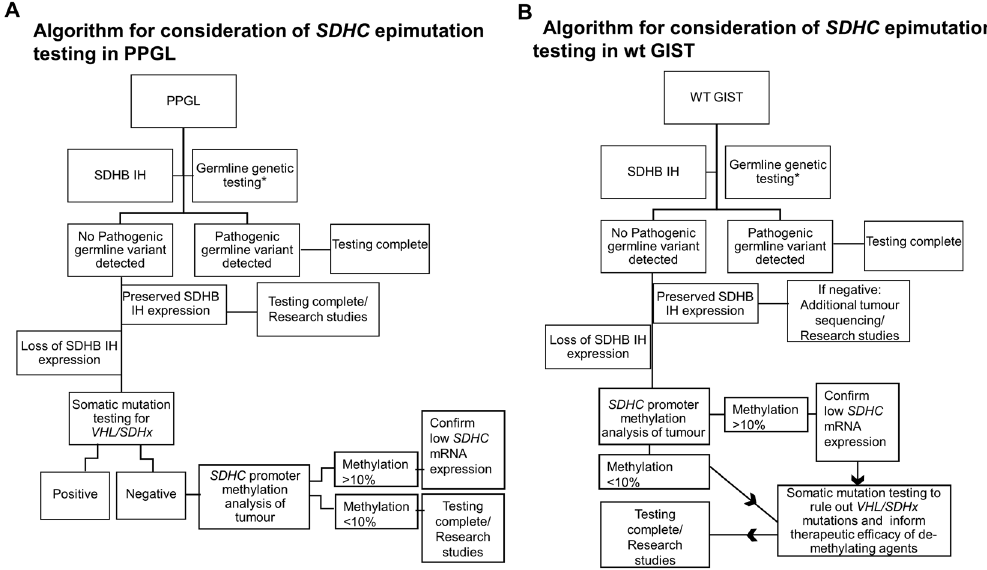
Figure 4. Illustrates a proposed work flow for the investigation of SDHC promoter methylation in a clinical setting for ( A ) PPGL and ( B ) wtGIST (defined as a GIST with no identified somatic mutation in KIT , PDGFRA OR BRAF ) * Next generation sequencing panel for PPGL including the genes; SDHA , SDHB , SDHC , SDHD , SDHAF2 , FH , TMEM127 , RET , VHL , MAX and including multiplex ligation dependent probe amplification for deletions and duplication. ** Next generation sequencing panel for wtGIST including the genes; SDHA , SDHB , SDHC , SDHD , KIT, PDGFRA, NF1 and including multiplex ligation dependent probe amplification for deletions and